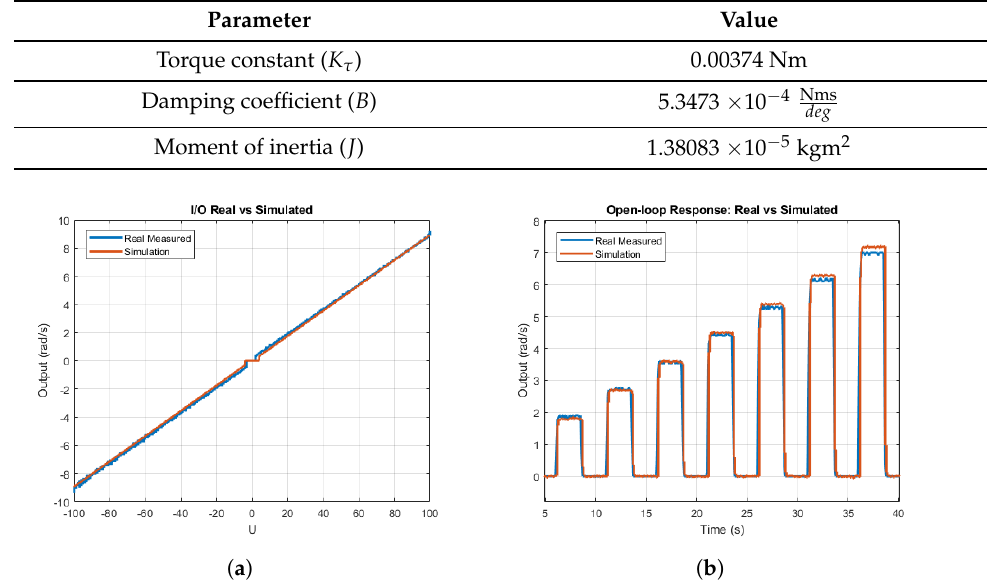
Figure 3. DC motor response: real vs. simulated. ( a ) Input–output characteristic response. ( b ) Open– loop step response.